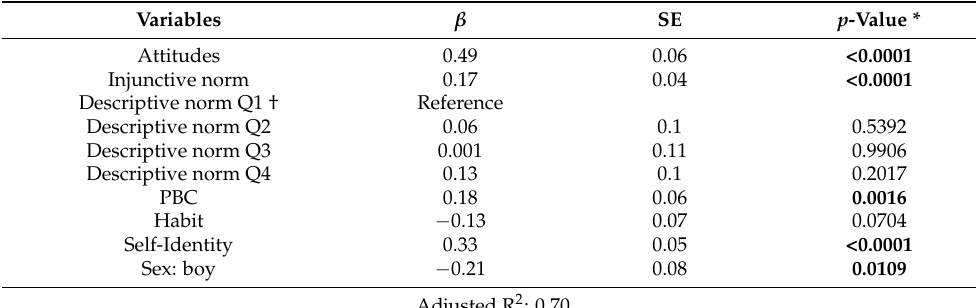
Table 4. Correlates of intention to limit recreational screen